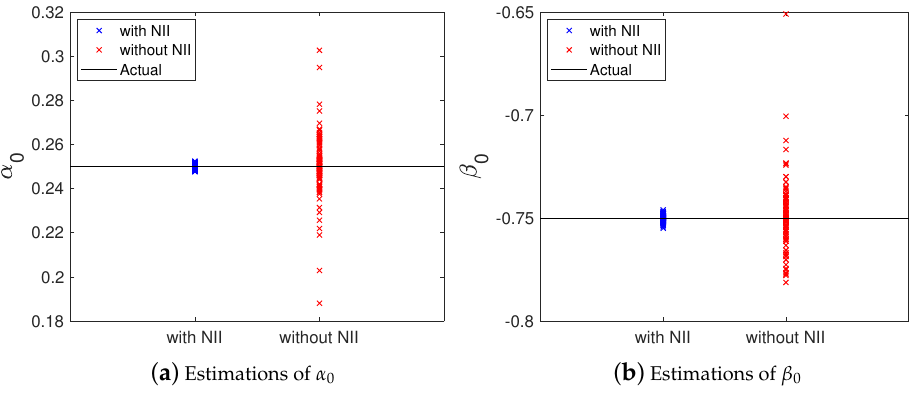
Figure 11. Estimations of α 0 and β 0 with and without the NII